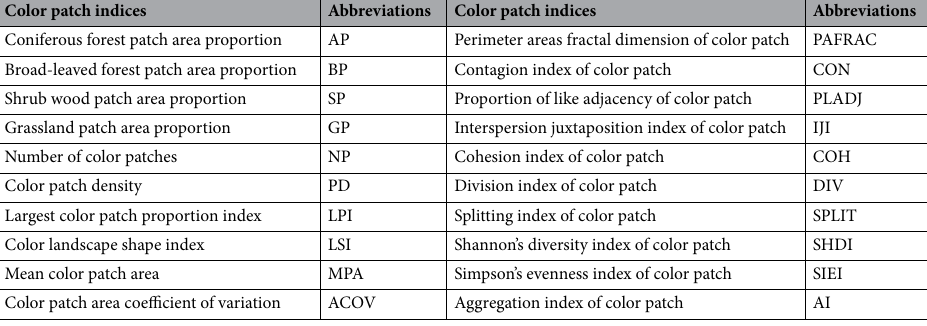
Table 1. Color patch